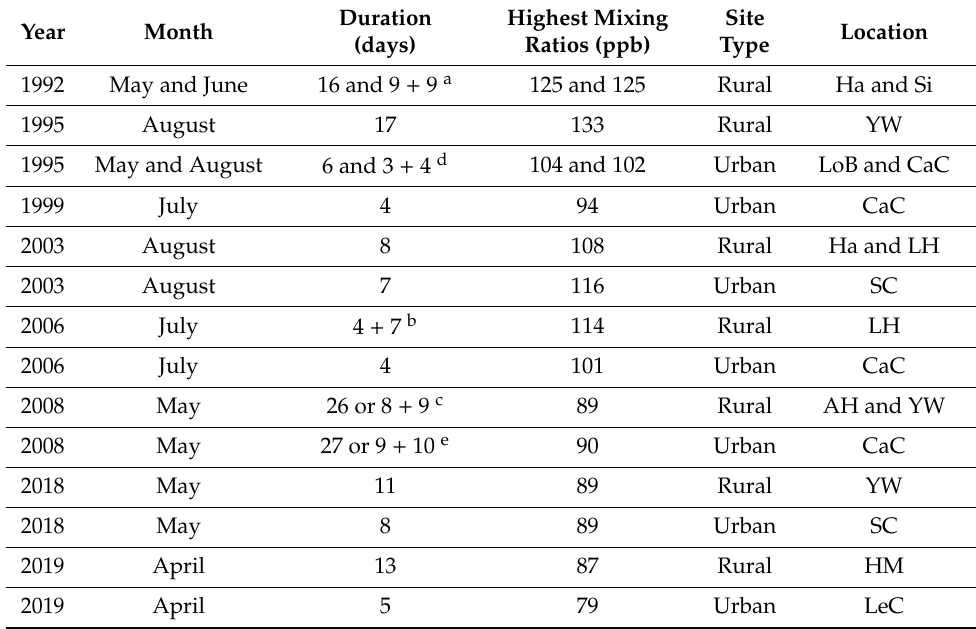
Table 2. Duration and magnitude of most severe episodes in rural and urban